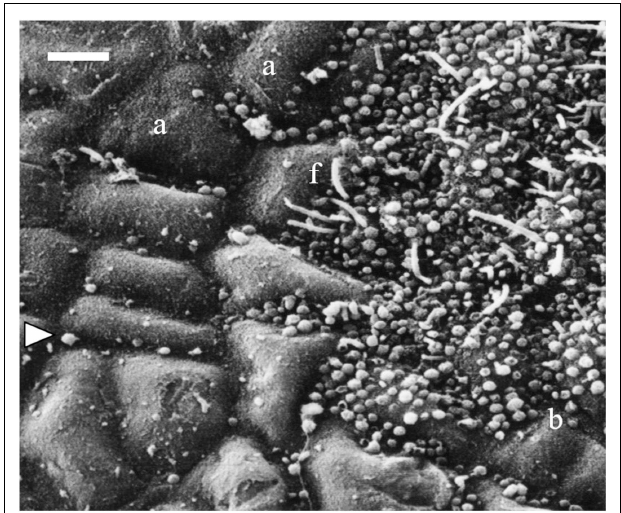
FIGURE 1 | Scanning electron micrograph showing a partially fouled surface of Fucus vesiculosus with unobstructed and masked areas of host tissue. The left side of the picture shows an apparently clean surface, the algal cells are visible (a) and also few coccoid bacteria (arrow) between them. In contrast, the right side of the picture shows a microbial film with coccoid bacteria (b) and filaments (f) covering the algal cuticle.The photo also illustrates the patchiness of microfouling on one host individual. Scale bar = 5 µ